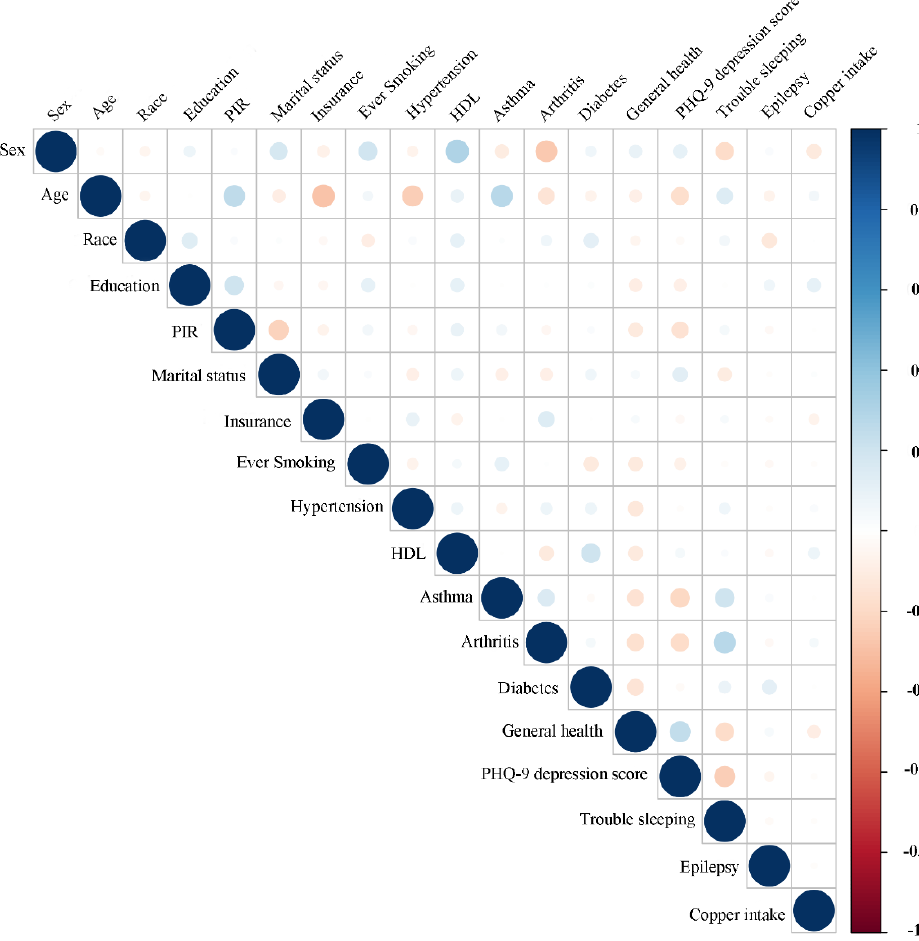
Figure 8. Correlation between the dietary copper intake and the baseline data in the stroke group. The color represents the association’s strength. The Pearson correlation coefficient was used to calculate the correlation.